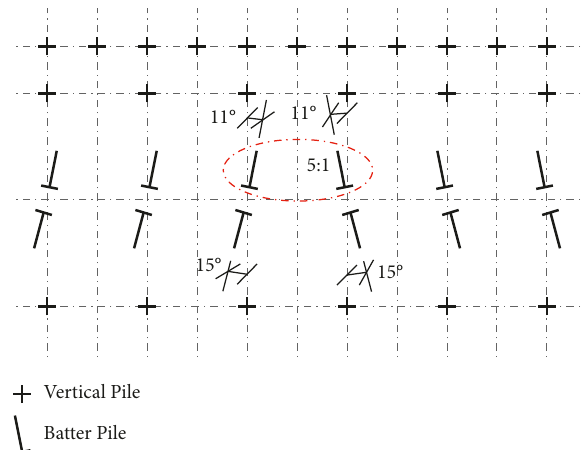
Figure 1: Orientation restriction between two